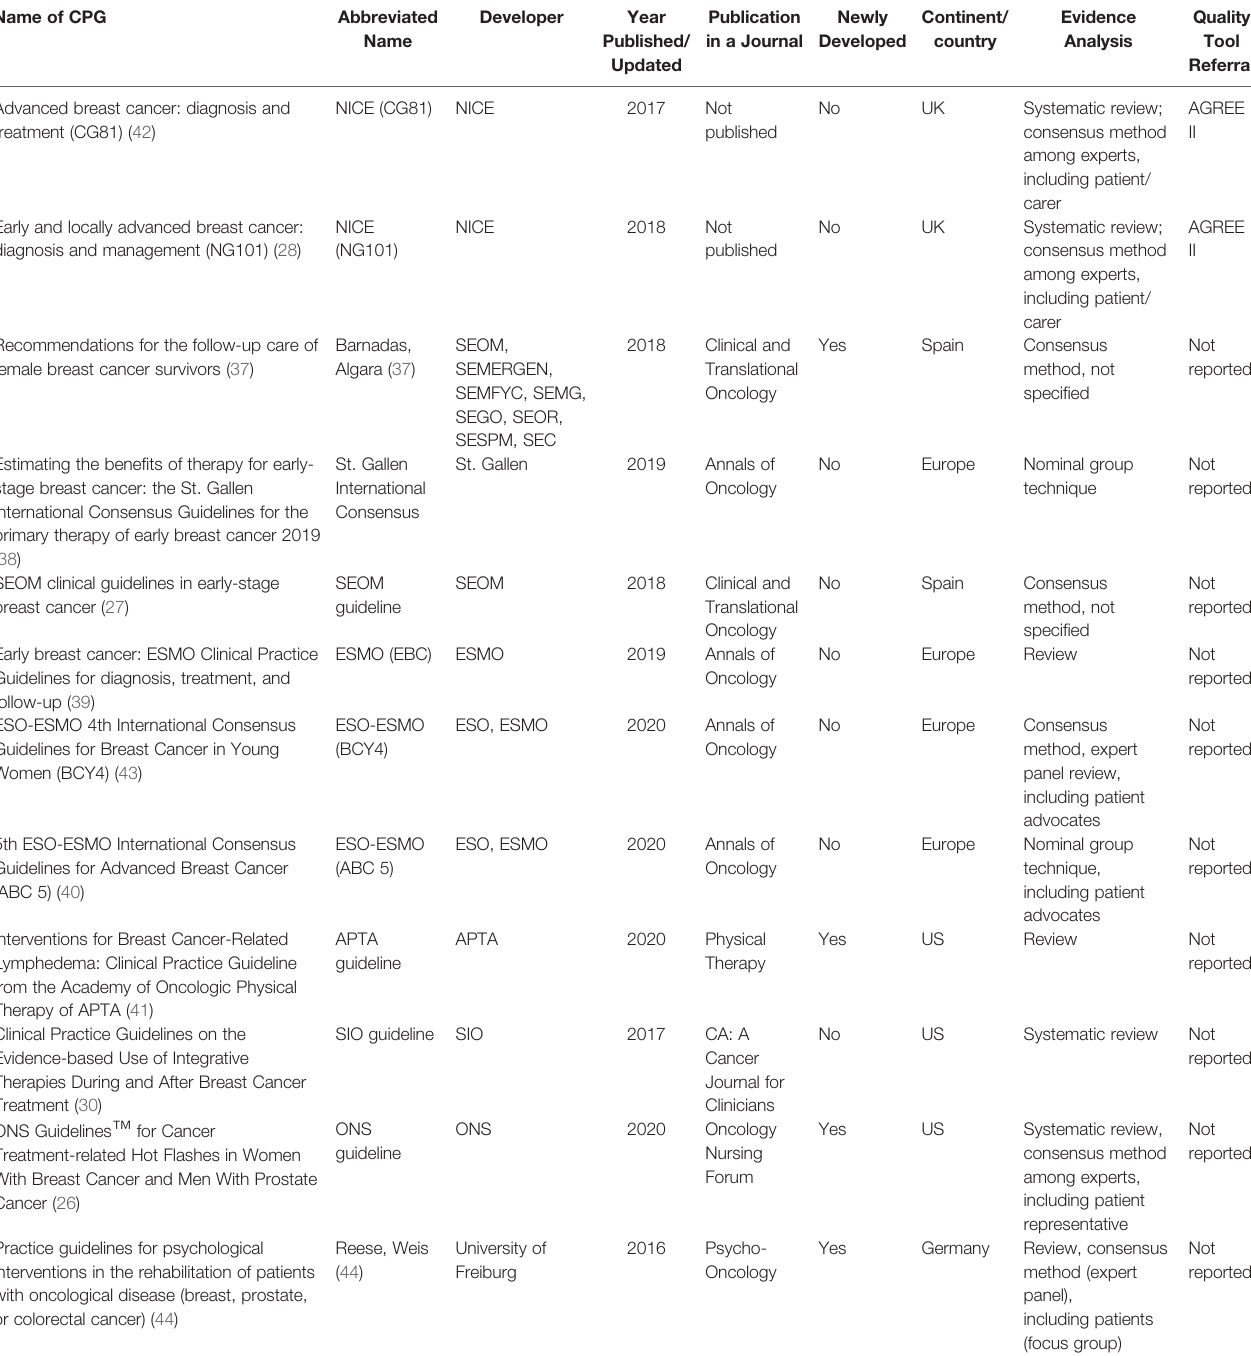
TABLE 2 | Characteristics of the included clinical practice